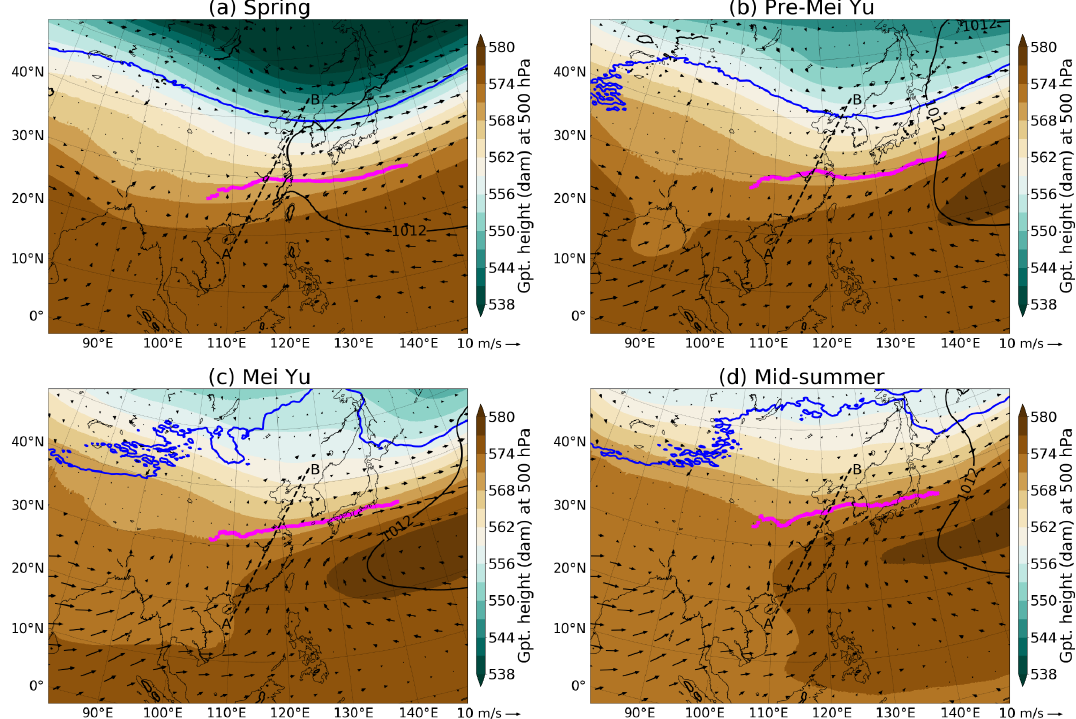
Figure 5. Dekadal mean of geopotential height at 500hPa (shading; dam), mean sea-level pressure (black contour; 1012hPa) wind vectors at 850hPa (arrows; ms − 1 ), and potential vorticity at 250hPa (blue contour; 2PVU). The magenta line indicates the climatological mean dekadal location of the EASMF at 850hPa. The AB dashed black line indicates the transect of the vertical cross-section in Fig. 10. The dekads representing the four stages of EASM progression (first dekad of May, first dekad of June, third dekad of June, second dekad of July, respectively) are selected according to Fig. 3. Data from ERA5 1979–2018